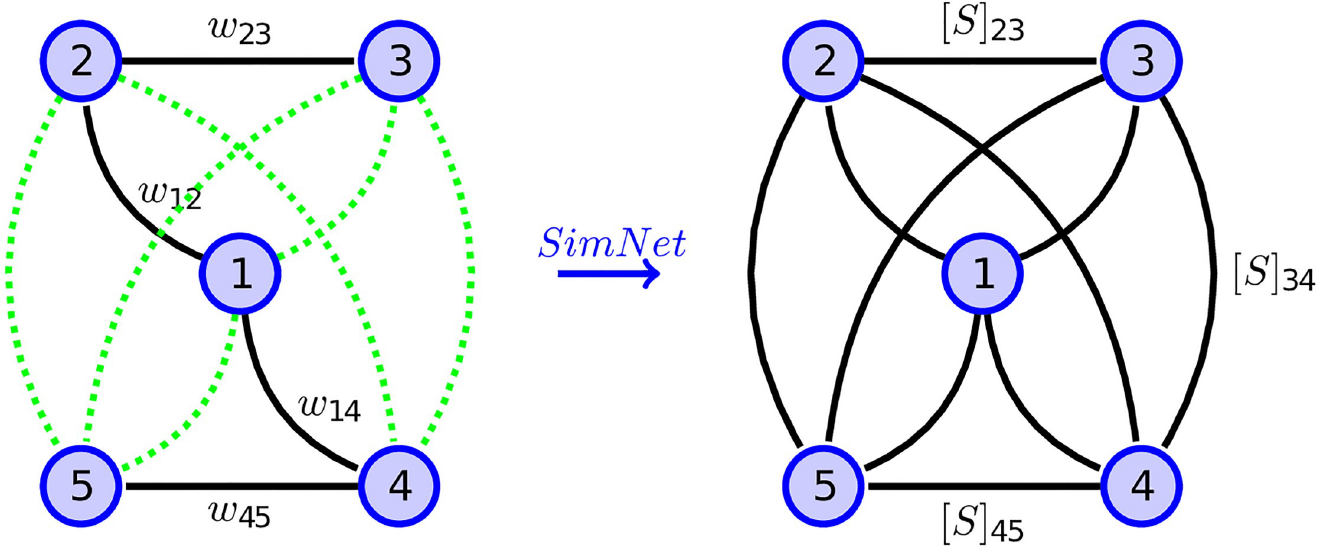
Fig 1. SimNet method. Defining a similarity matrix based on a new way of measuring the closeness between nodes.